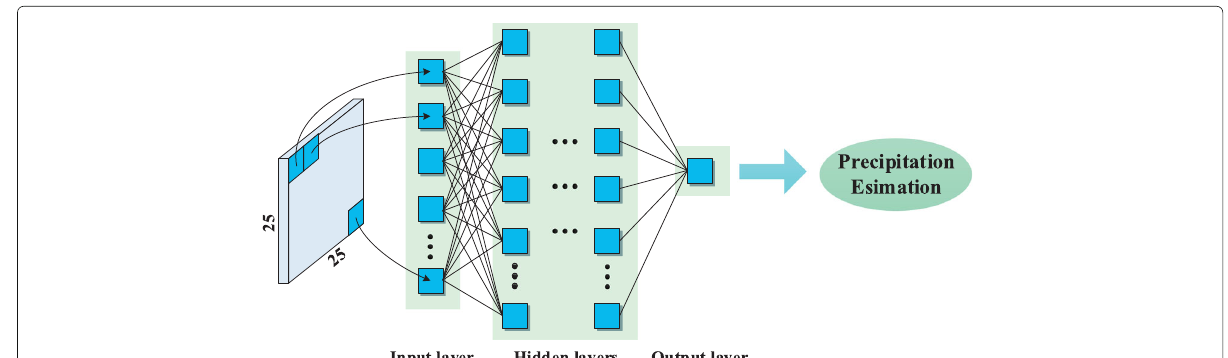
Fig. 4 Details of